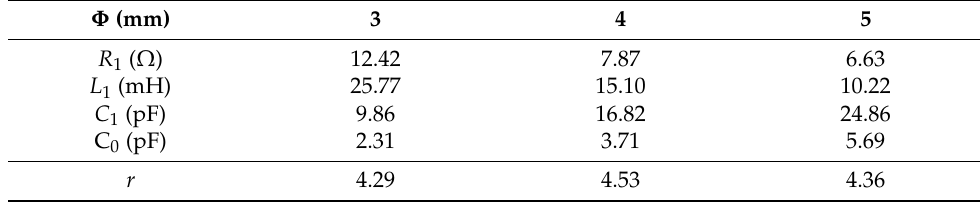
Table 2. Equivalent parameters of QCM resonator devices with different electrode diameters.